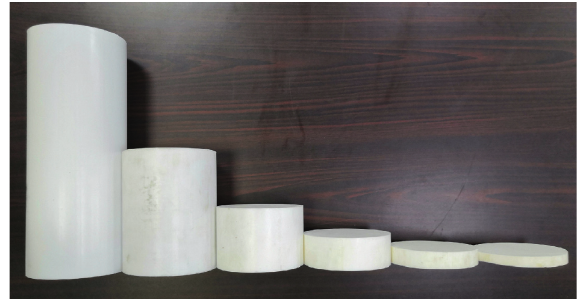
Figure 11: Teflon samples with different